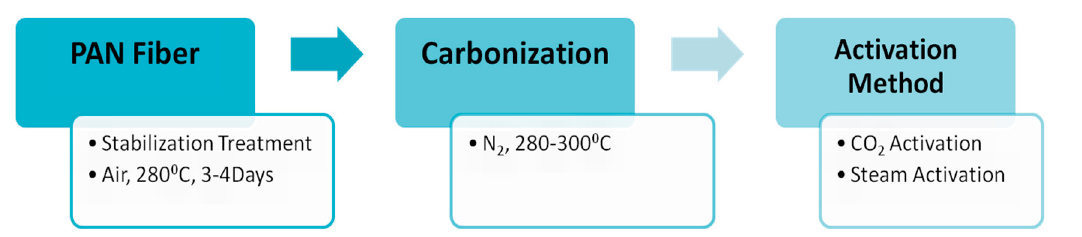
Figure 6. Activated carbon derived from PAN fibers.